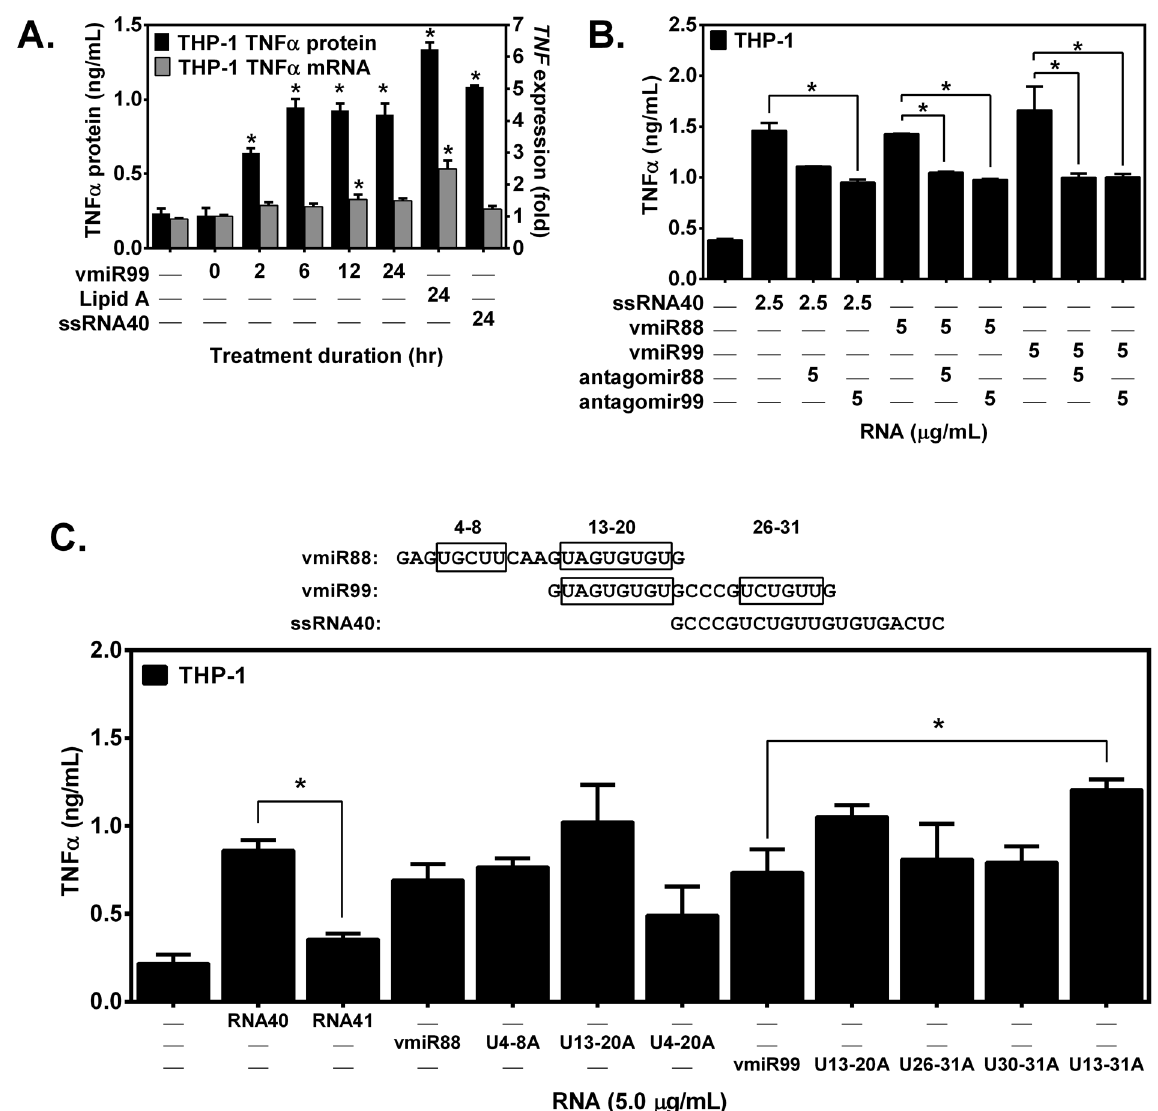
Figure 4. Viral miRNAs stimulate THP-1 macrophages to release TNF a rapidly in a vmiR sequence-dependent manner, and release is inhibited by antagomirs. A : THP-1 macrophages were treated with vmiR99 (1.0 m g/mL) at the indicated time points (hr) or with Lipid A or ssRNA40 (24 h). Conditioned medium was analyzed by ELISA. Total RNA was isolated from cell extracts, and expression of TNF (normalized by GAPD ) was analyzed by qRT-PCR. Results are the average of three independent experiments done in duplicate. B : THP-1 macrophages were pre-treated with antagomir (5.0 m g/mL for 1 h) followed by treatment with ssRNA40 (2.5 m g/mL), vmiR88 (5.0 m g/mL) or vmiR99 (5.0 m g/mL for 24 h), and conditioned medium analyzed by ELISA. C : Sequence variants of vmiR88 and vmiR99 can elicit TNF a release by THP-1 macrophages. Variants of vmiR88 or vmiR99 were chemically synthesized by substituting the uridine residues of U-rich motifs (boxed regions) for adenine residues. VmiRs and variants (5.0 m g/ mL) were applied to cells for 24 h. Supernatants of conditioned medium were assayed for TNF a by ELISA. *, p , 0.05. simply A-content determines function of vmiR99. The uptake efficiency of LyoVec-vmiR complexes was not measured. The apparent potency of vmiRs to signal TNF a release by THP-1 macrophages (Fig. 4B, C) is lower than for AM (Fig. 3D), which could be due to different efficiencies of LyoVec-vmiR uptake in the two cell types.